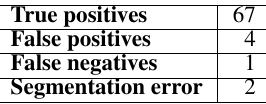
Table 4. Result city center